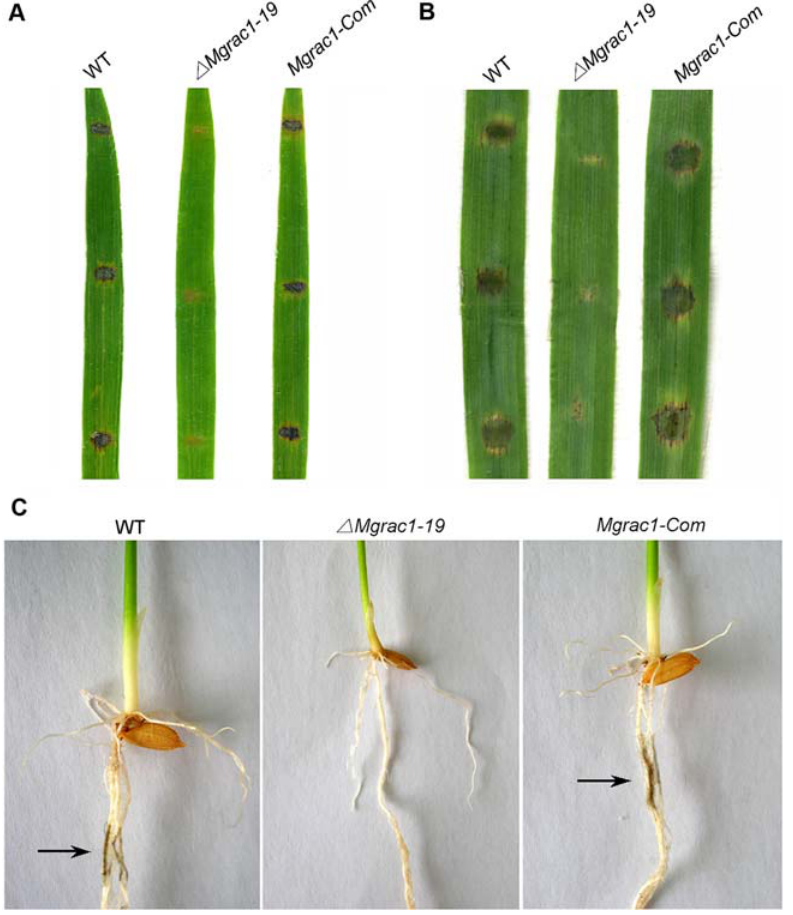
Figure 3. The Mgrac1 deletion mutant is nonpathogenic. (A) Disease symptoms on the wounded leaf tissues of rice inoculated by mycelial plugs from WT (70-15), D Mgrac1-19 , and Mgrac1-Com . Typical leaves were photographed 5 days after inoculation. (B) Disease symptoms on the wounded leaf tissues of barley inoculated by mycelial plugs from WT, D Mgrac1-19 , and Mgrac1-Com . Typical leaves were photographed 4 days after inoculation. (C) Blast symptoms on rice roots. Arrows show necrotic